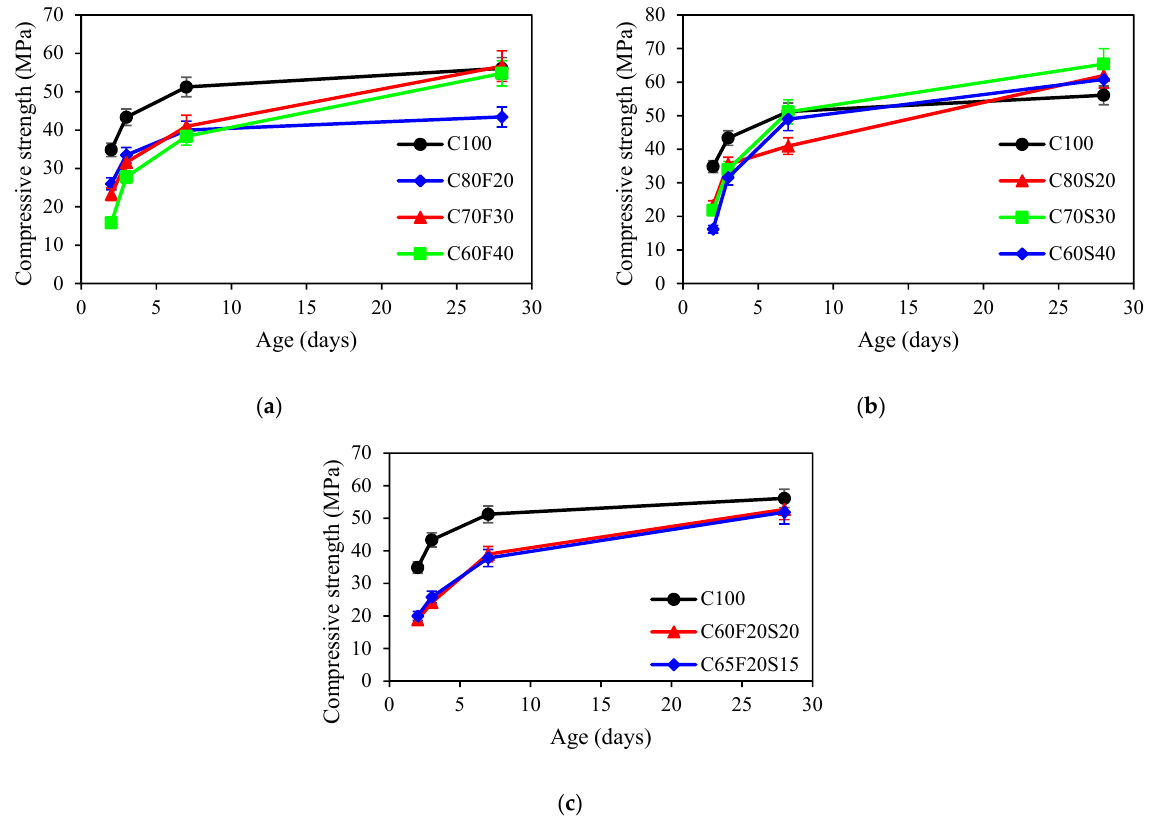
Figure 4. Compressive strength of concrete: ( a ) fly ash group; ( b ) GGBFS group; ( c ) ternary binder group. Figure 5 showed the development of the splitting tensile strength of concrete. For concrete mixes with fly ash, the splitting tensile strength at the age of 28 days after casting for C80F20, C70F30, and C60F40 were 5.35, 4.93, and 4.02 MPa, respectively. It was seen that the higher fly ash content, the lower the average value of splitting tensile strength